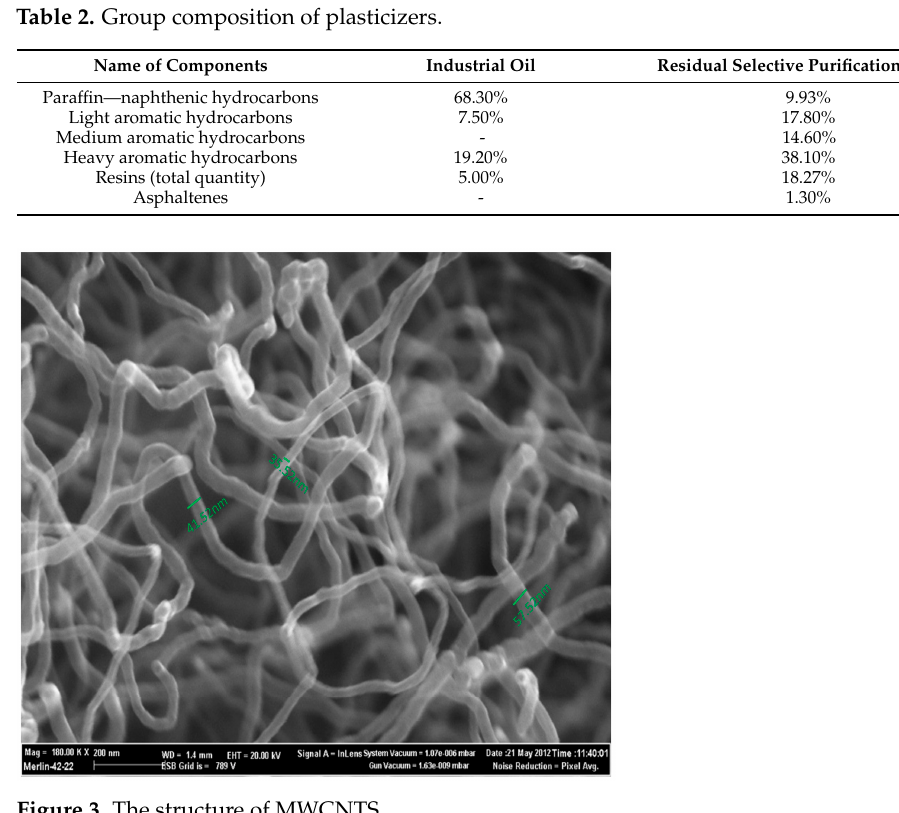
Figure 3. The structure of